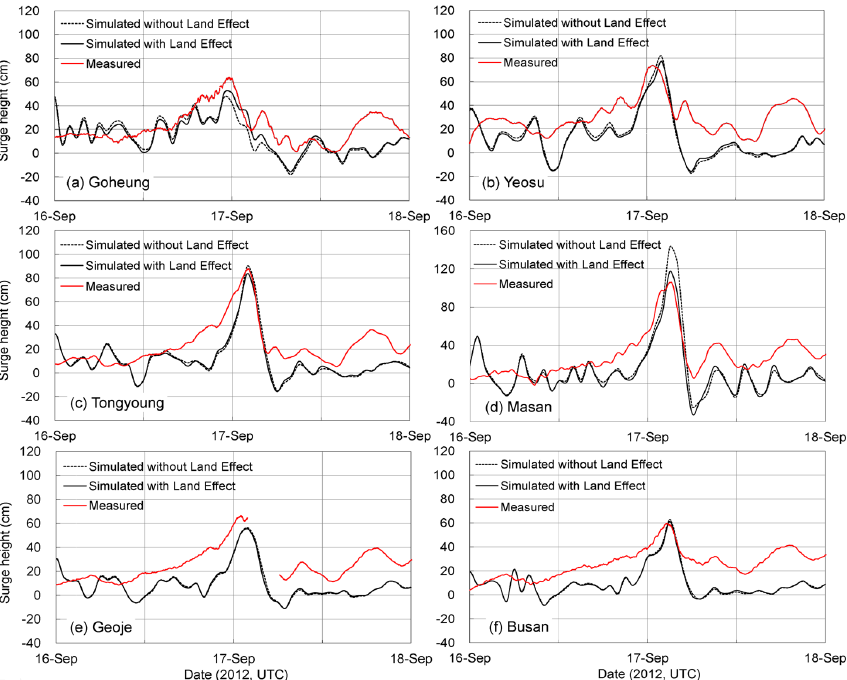
Figure 10. Comparison of the surge height on the influence of the land roughness effect during typhoon Sanba ( (a) Goheung; (b) Yeosu; (c) Tongyoung; (d) Masan; (e) Geoje; (f) Busan).